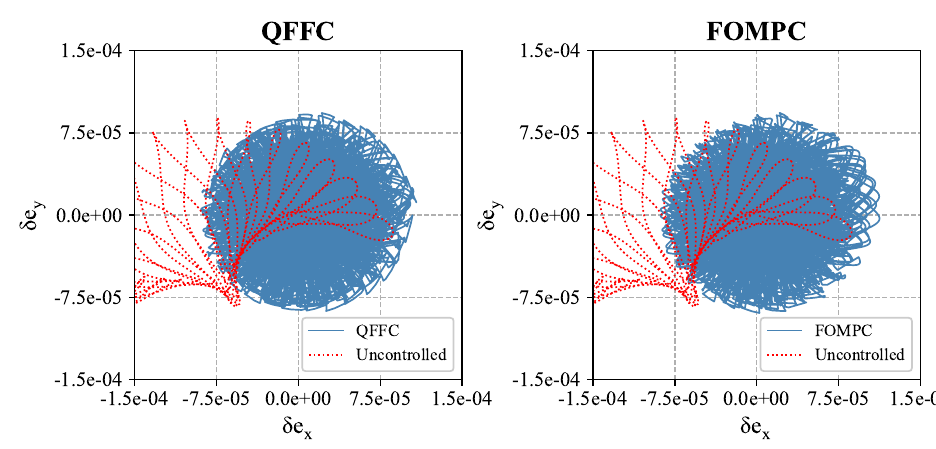
Figure 5. The comparison of the trajectories in the ( δ e x , δ e y ) plane.